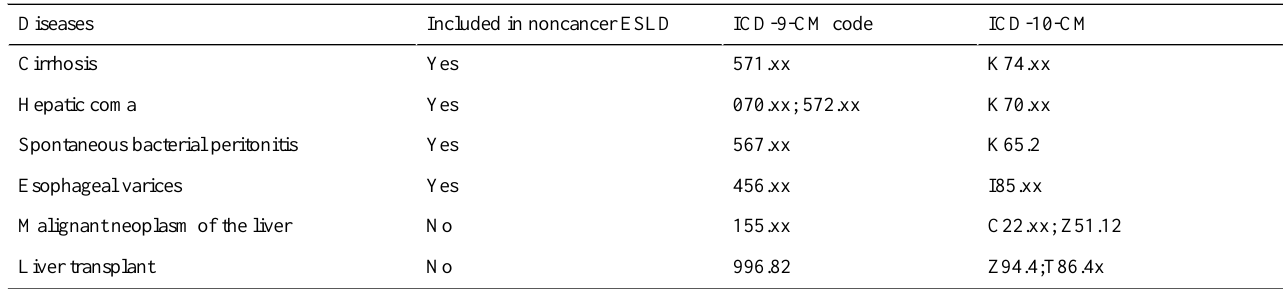
Table 1. International Classification of Diseases (ICD)-9-Clinical Modification (CM) and ICD-10-CM codes for noncancer end-stage liver disease (ESLD).